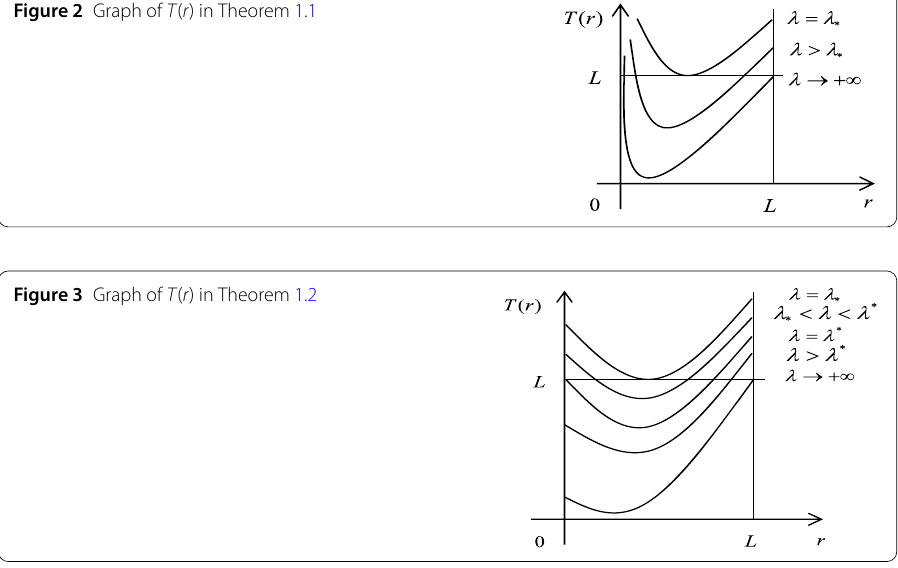
Figure 2 Graph of T ( r ) in Theorem 1.1